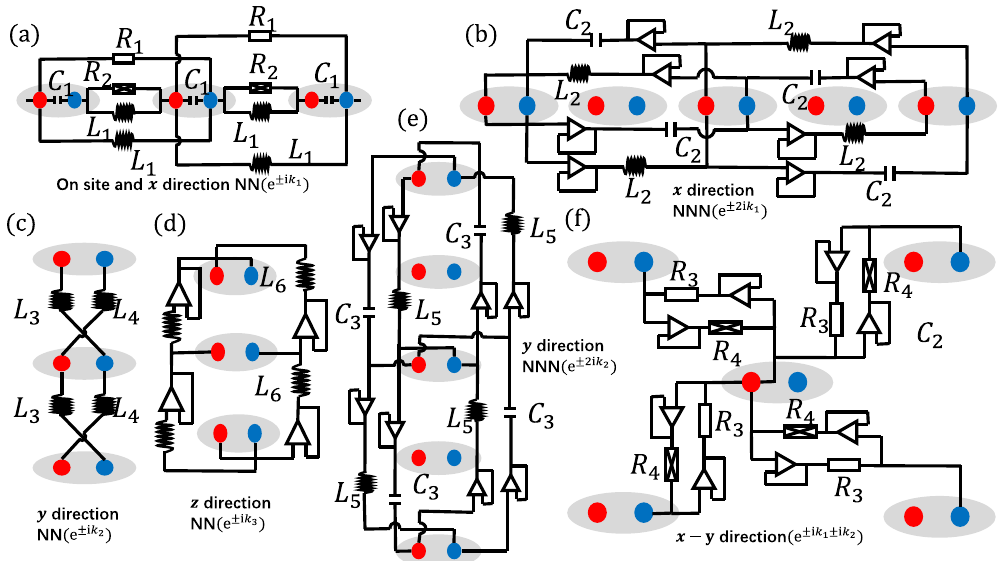
Fig. 8 Constituents of the non-Hermitian Trefoil knot circuit. ( a ) On-site hopping and nearest-neighbor (NN) hopping in the x direction, ( b ) next-nearest- neighbor (NNN) hopping in the x direction, ( c ) NN hopping in the y direction, ( d ) NN hopping in the z direction, ( e ) NNN hopping in the y direction, and ( f ) diagonal hopping in the x – y